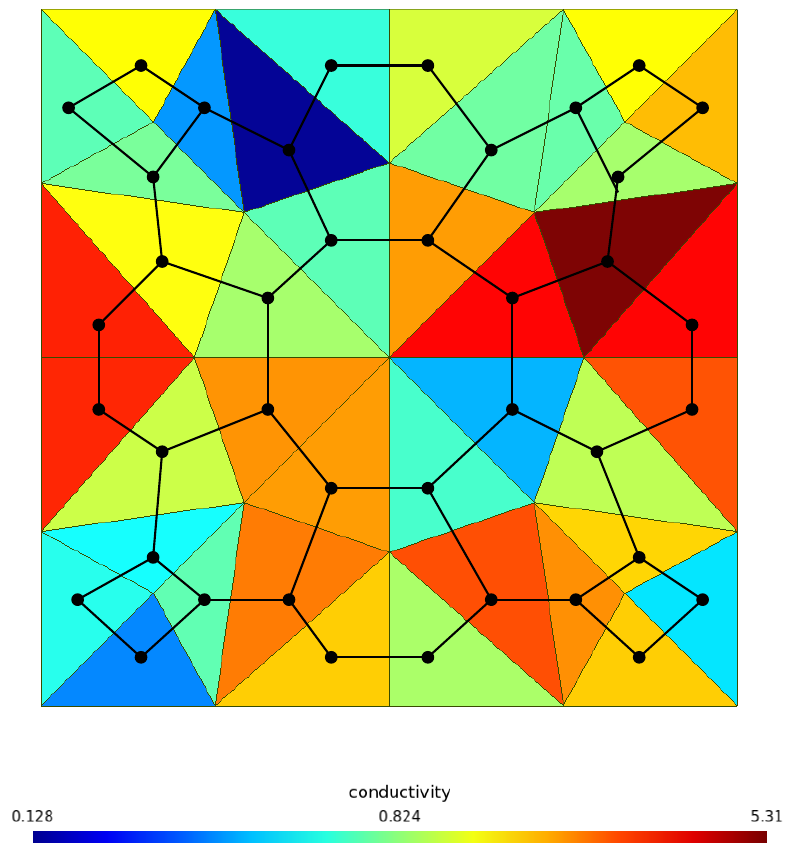
Figure 2. An illustrative example of a random field on an unstructured mesh with the corresponding graph